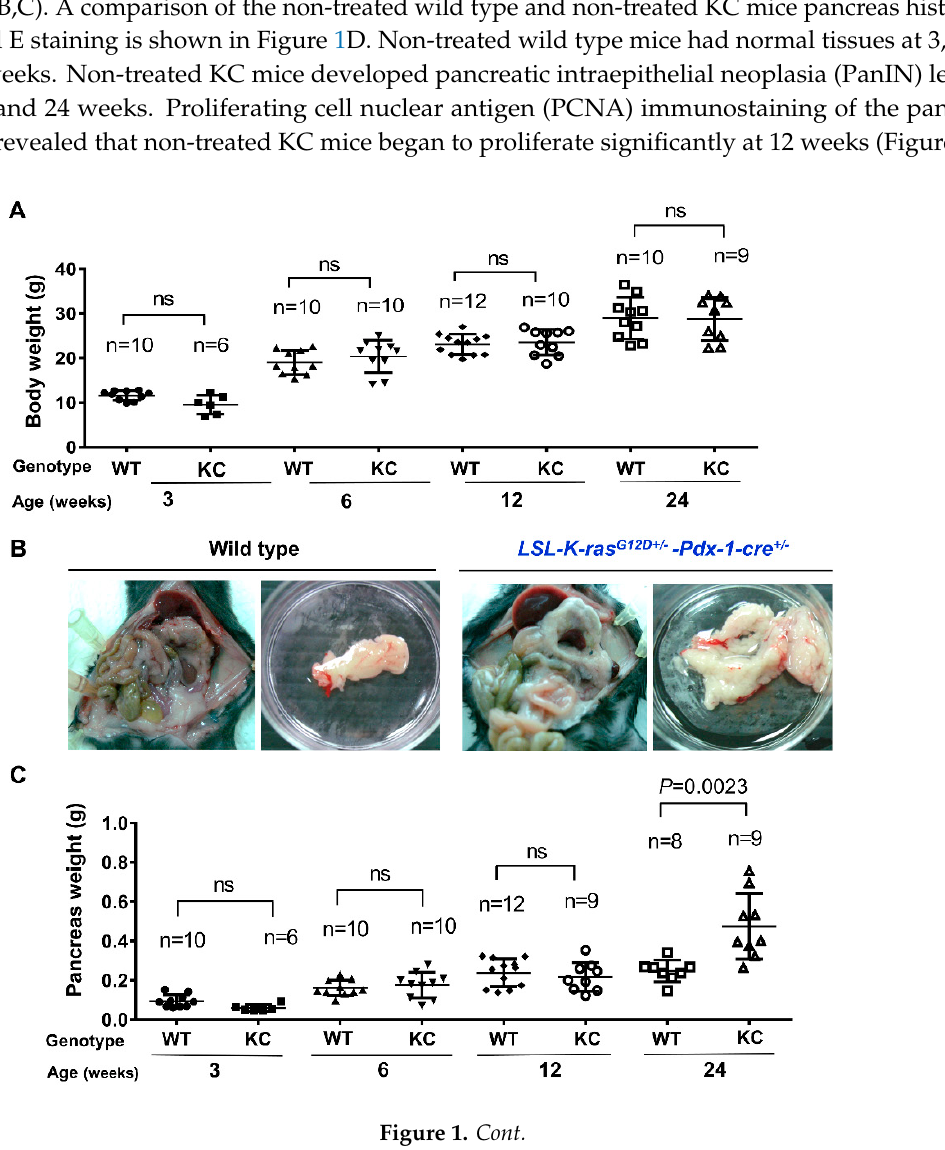
Figure 1. Accelerated pancreatic ductal adenocarcinoma (PDAC) progression in a transgenic LSL-K- ras G12D+/- - Pdx-1-cre +/- mouse model. ( A ) No significant difference was observed between the body weights of non-treated KC mice and non-treated wild-type mice at 3, 6, 12, and 24 weeks. ( B ) Comparison of pancreas size for KC mice with age- and sex-matched wild type mice at 24 weeks. ( C ) KC mice showed significantly increased pancreas weights ( p = 0.0023) at 24 weeks. ( D ) Representative H and E staining images of the mouse pancreas at 3, 6, 12, and 24 weeks. KC mice developed pancreatic intraepithelial neoplasia (PanIN) lesions at 6, 12, and 24 weeks (scale bar, 200 µm). ( E ) Representative images of proliferating cell nuclear antigen (PCNA) staining of the mouse pancreas, indicating a significant increase in cell proliferation at 12 weeks in KC mice (Figure 1E) (scale bar, 50 µm). WT, wild type; KC, LSL-K-ras G12D+/- - Pdx-1-cre +/- .